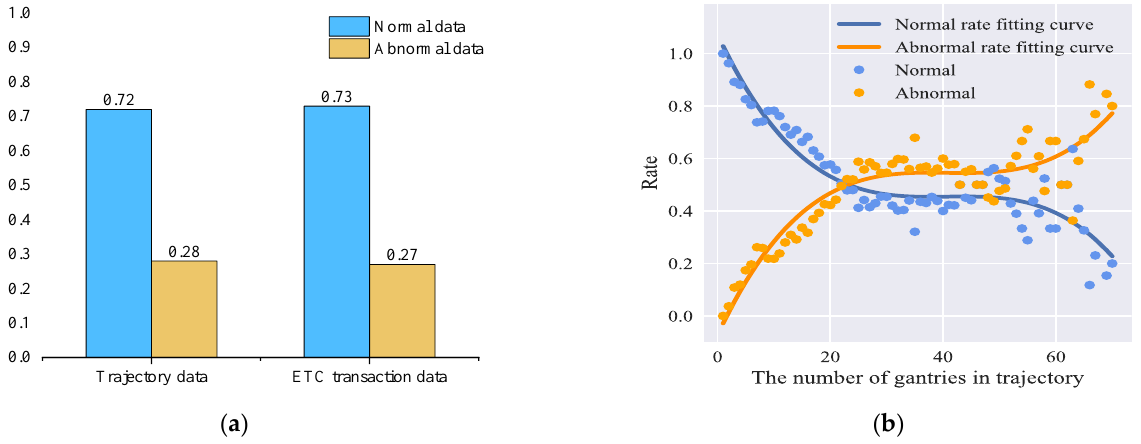
Figure 7. Analysis of the experimental data: ( a ) overview of abnormal transaction data; ( b ) the correlations of the numbers of ETC gantries in the vehicle trajectories.